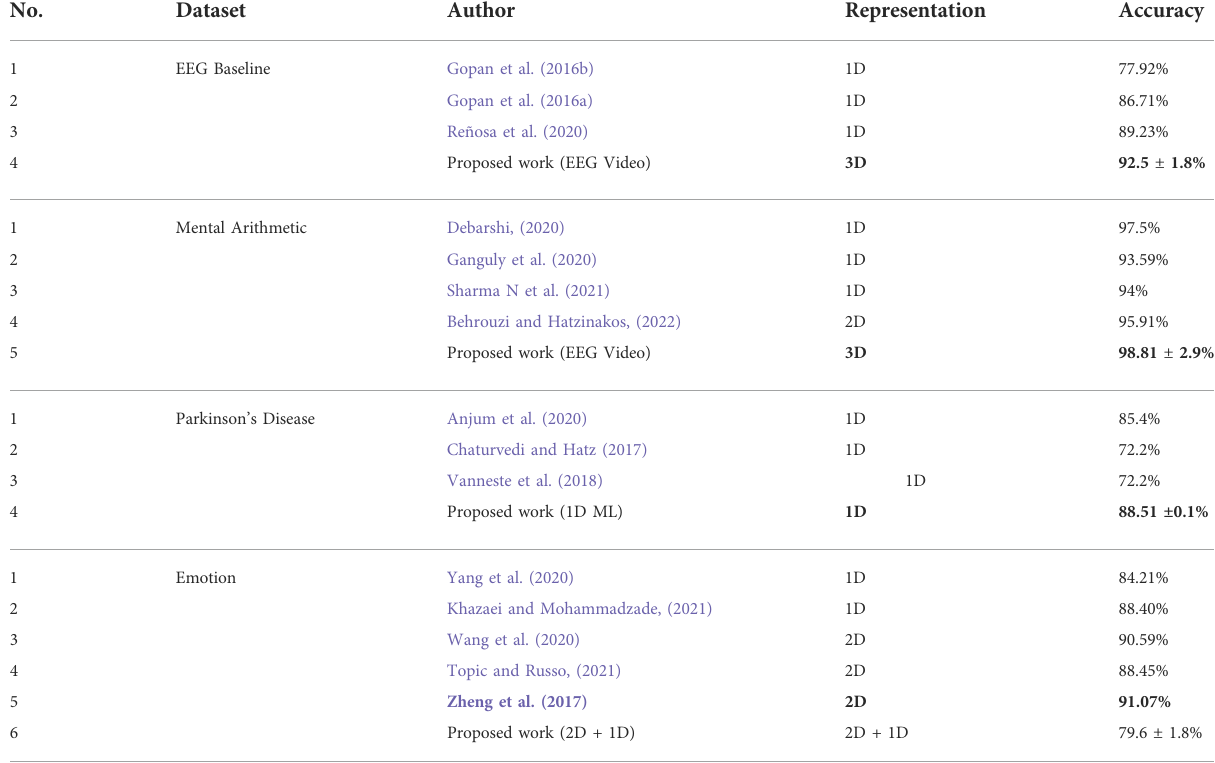
Bold values indicate the highest accuracy obtained using that methodology for a particular